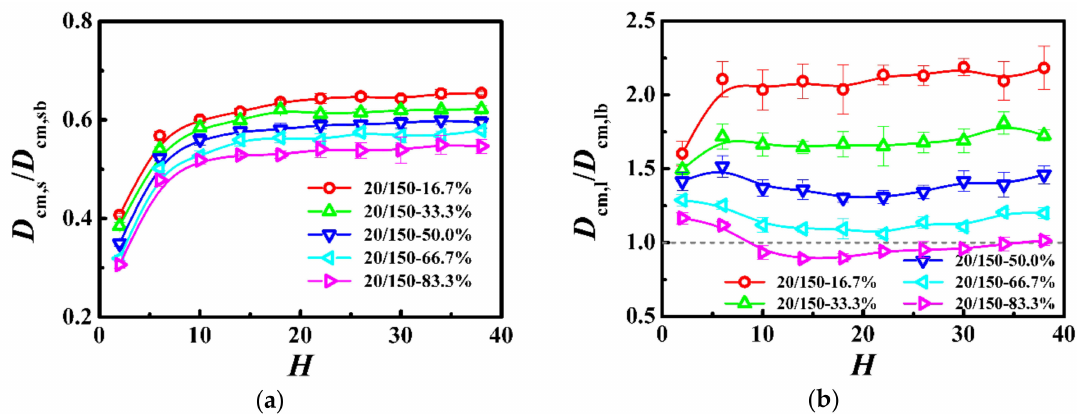
Figure 4. Normalized self-diffusion coefficient of the center-of-mass for ( a ) shorter ( D cm,s / D cm,sb ) and ( b ) longer ( D cm,l / D cm,lb ) chains as a function of film thickness ( H ) in the model system of N s = 20 and N l =